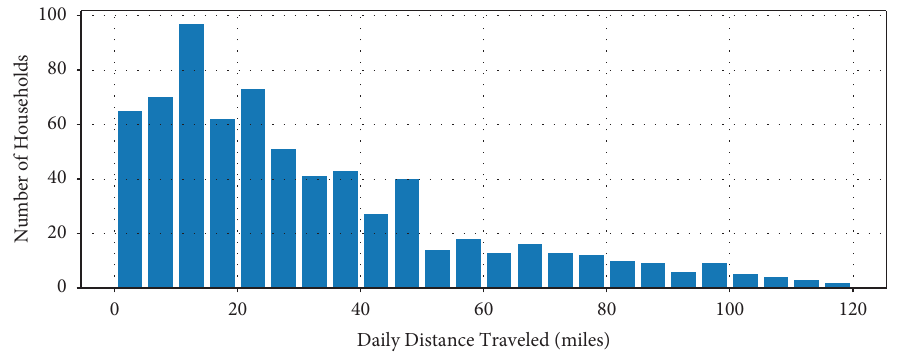
Figure 5: Daily distance traveled distribution.